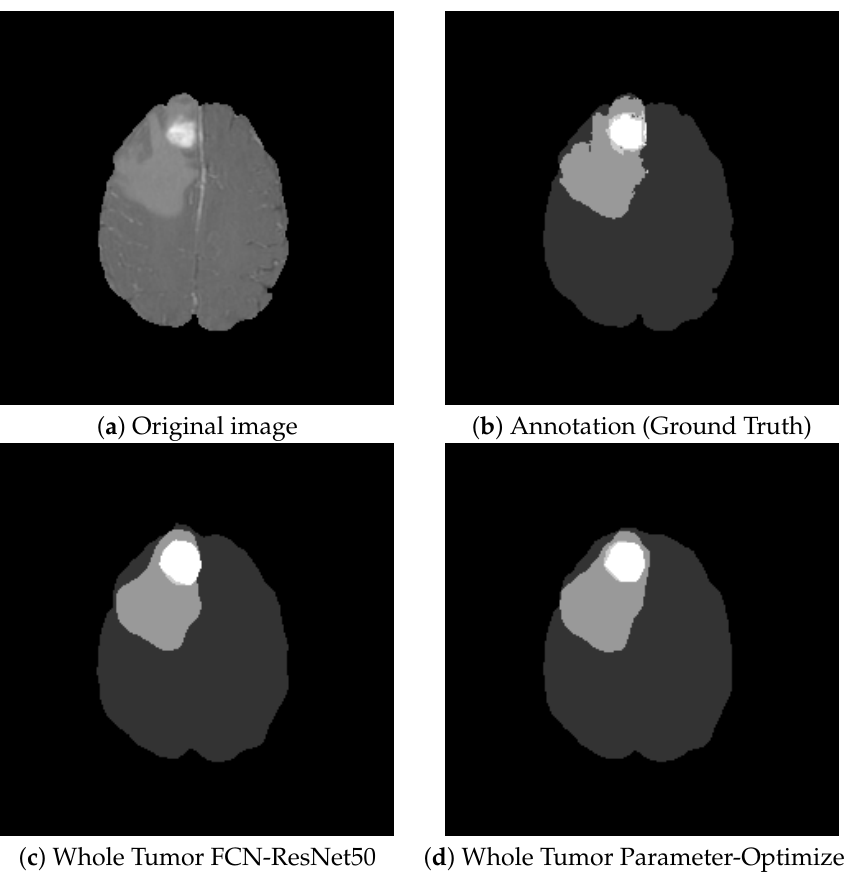
Figure 11. Comparison of FCN and Parameter-Optimized FCN: visually, the segmentations can barely be